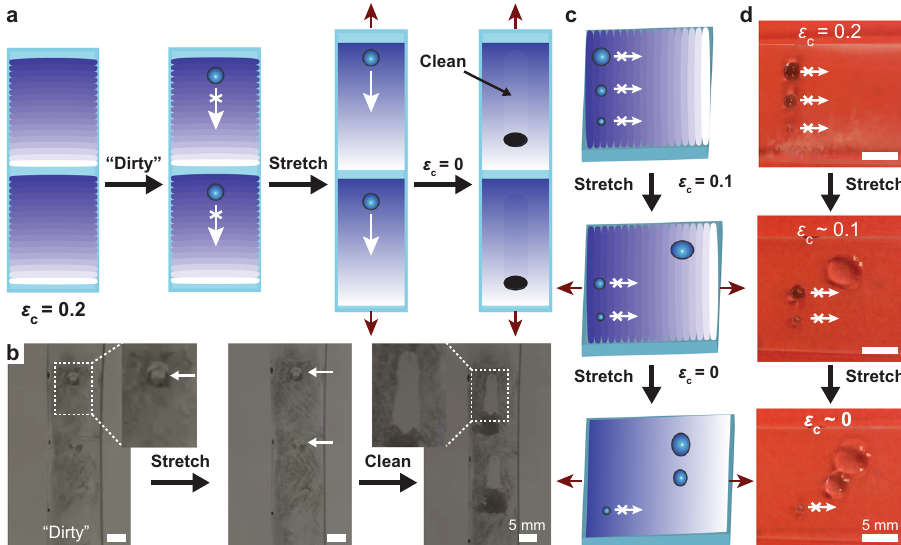
Fig. 5 Mechanically activated self-cleaning surfaces and mechanically controlled droplet sorting devices. a Schematic illustration of the use of mechanical deformations to activate droplet transport and thus self-cleaning functionality. b Optical micrographs of the mechanically activated self- cleaning process (insets are higher magni fi cation of the highlighted regions, and compressive strain, ε c is given). c Schematic illustration of the operation of a mechanically controlled droplet sorting device. d Optical micrographs of a droplet sorting device in operation. Transport of a 5 µ L droplet occurs following activation of the gradient using a compressive strain of ε c = 0.1. Transport of a 2.5 µ L droplet occurs following maximal activation of the gradient